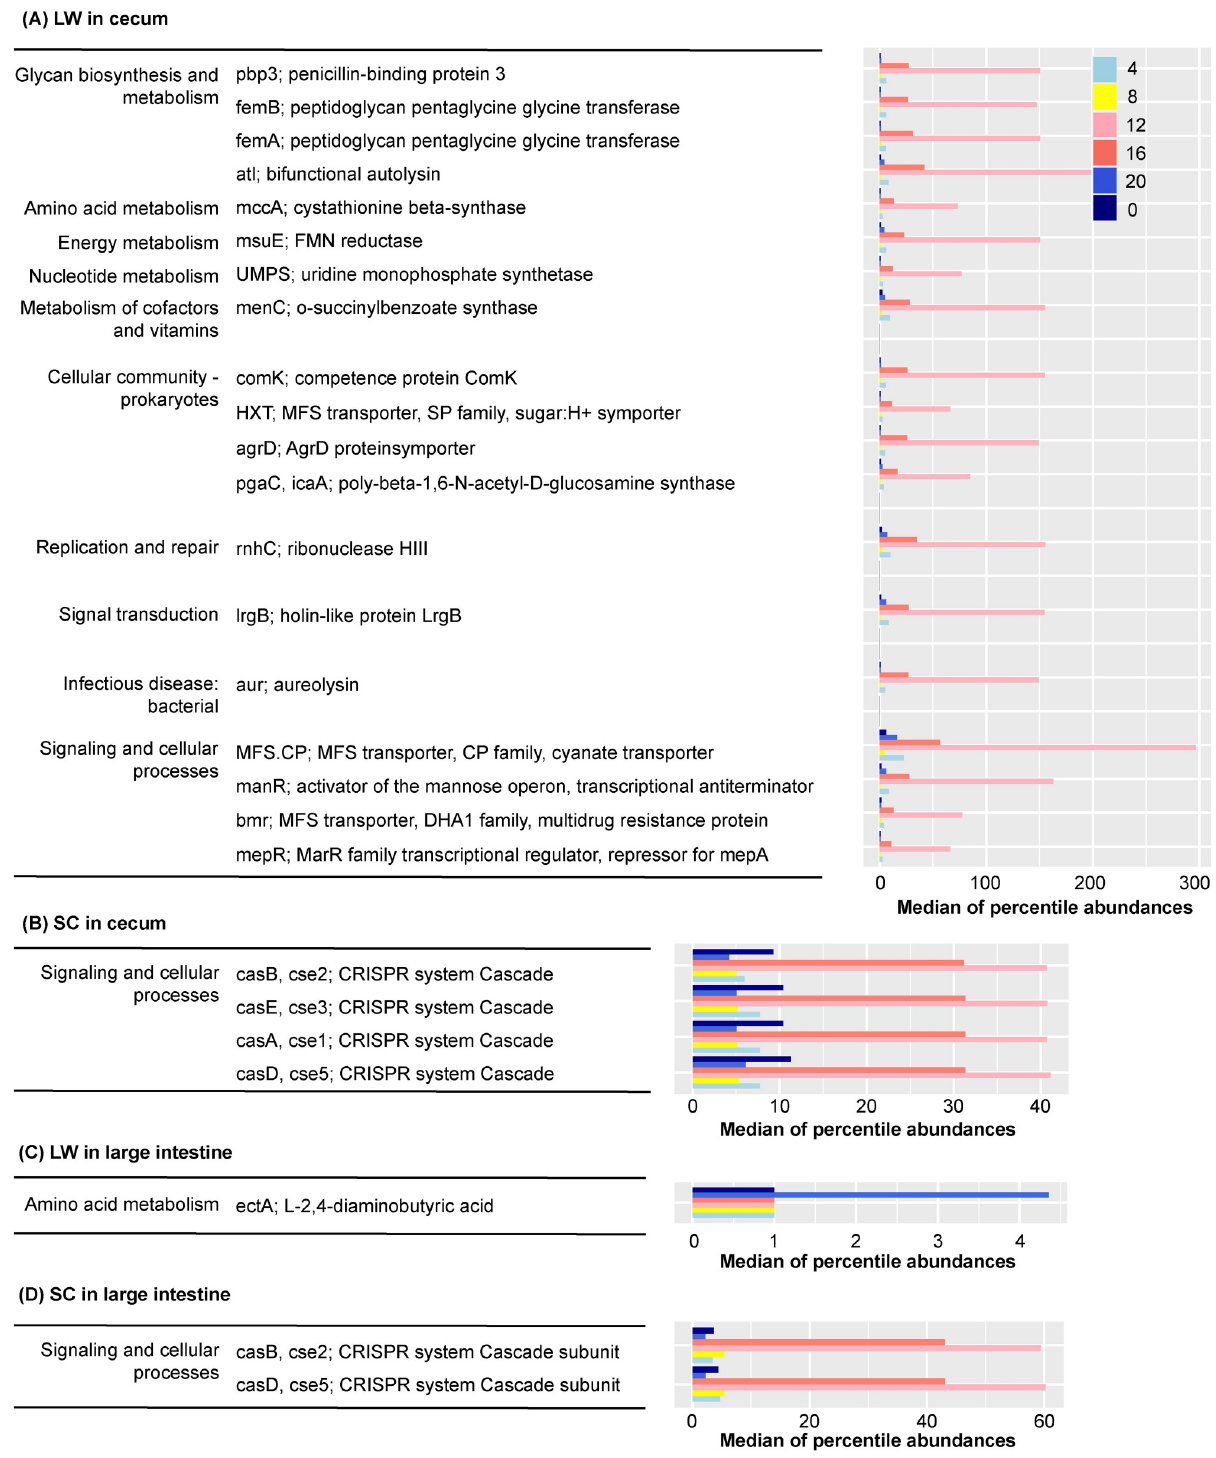
Fig 5. Pathways predicted to show daily changes. Predicted daily changes in the KEGG pathways in the cecum under (A) LW and (B) SC conditions. Predicted daily change in the KEGG pathways in the large intestine under (C) LW and (B) SC conditions. PICRUSt prediction results that focused on daily changes of gut microbiome in cecum and large intestine of CBA/N mice. The left legend represents the KEGG pathways determined by ANCOM to be significantly different by sampling time (left; level 2, right; level 6). The bar graph on the right represents the median of percentile abundances each functional